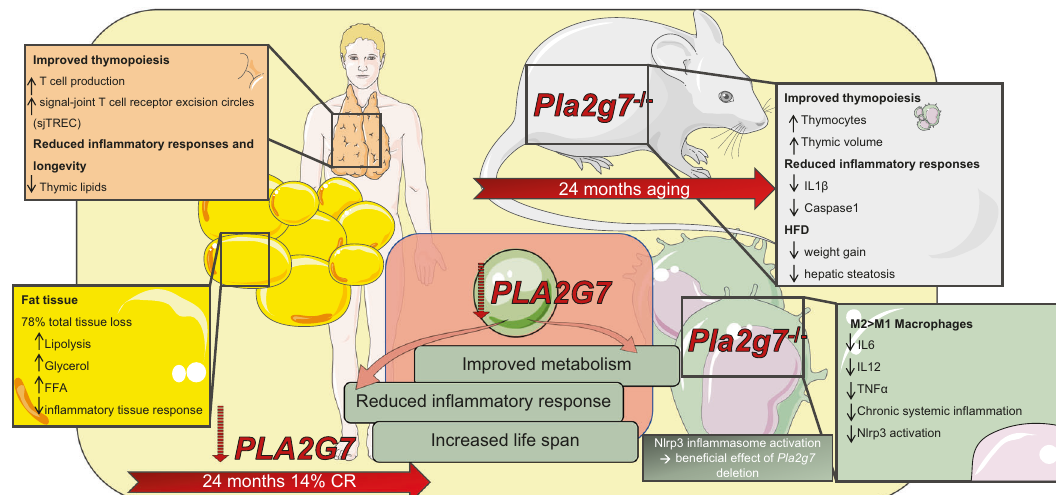
Fig. 1 The Improvement of health and lower in fl ammation through Caloric Restriction (CR) via Pla2g7 downregulation. Improved thymopoiesis is found by enhanced T cell generation and greater levels of signal-joint T cell receptor excision circles (sjTREC) after a 14% CR for 24 months. Thymic lipid buildup after 24 months of CR was reduced in healthy mid-aged humans, which was used to estimate longevity. After CR, adipose tissue reduction accounted for 78% of overall weight loss. Increased lipolysis, as demonstrated by higher levels of glycerol and free fatty acids (FFA), helped to create an anti-in fl ammatory environment and improved adipose tissue metabolism. Downregulation of platelet activating factor acetyl hydrolase (PLA2G7) in humans experiencing CR is thought to be the origin of these effects, which mediates immune-metabolic effects that contribute to lower in fl ammation and a longer lifespan. The CRISPR Cas technique was used to generate Pla2g7 − / − knockout mice, which were protected from weight gain and steatosis when fed a high-fat diet (HFD). Thymocyte production and thymic volume were raised in these animals, highlighting the regulatory effects of PLA2G7 in the human cohort. When compared to wildtype controls, the reduction of pro-in fl ammatory cytokines including Interleukin-1ß (IL1ß) and Caspase 1 contributed to the better phenotype of these mice after 24 months of age. Furthermore, these Pla2g7 − / − mice revealed a shift in macrophage polarization, with fewer pro-in fl ammatory M1 macrophages and more immunoregulatory M2 macrophages circulating in the bloodstream. In PLA2G7-depleted macrophages, total systemic in fl ammation was reduced, resulting in signi fi cantly reduced Interleukin 6 (IL6) and Interleukin 12 (IL12) levels as well as tumor markers. This fi gure was designed using